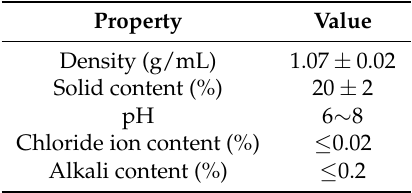
Table 1. The property of water-reducing